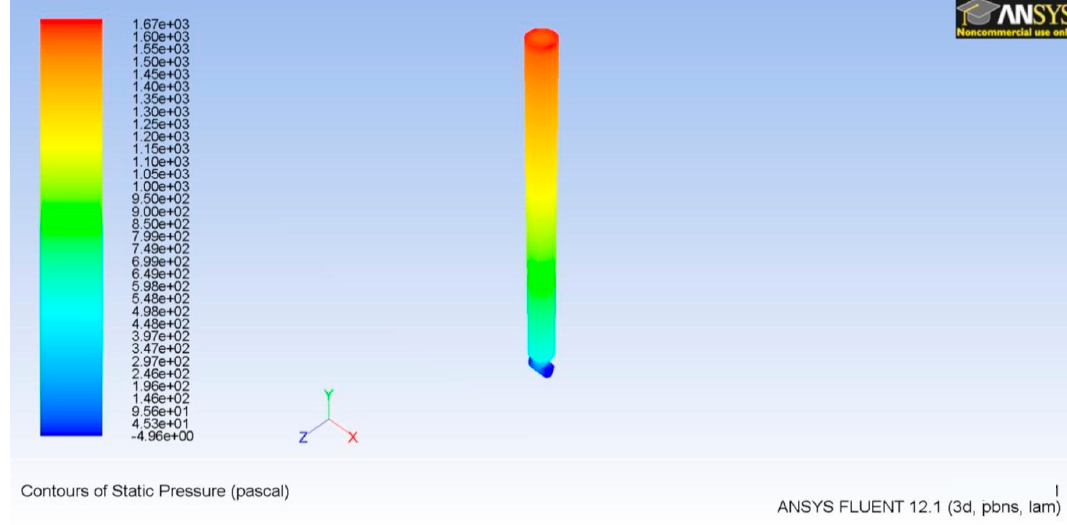
Figure 6. Contours of pressure for the microneedle.